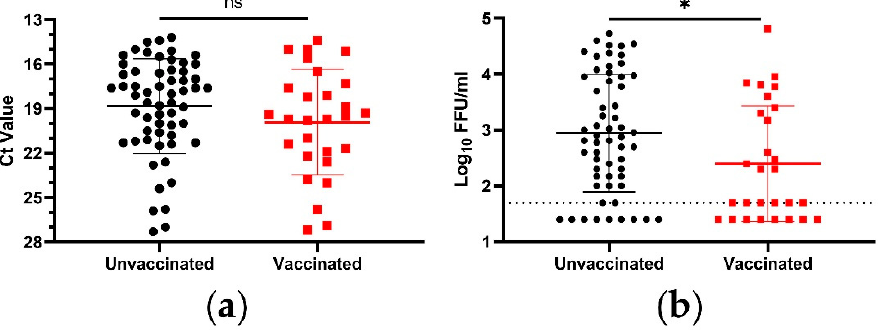
Figure 1. Viral load in NP swabs from asymptomatic Delta variant SARS-CoV-2 infections. ( a ) SARS-CoV-2 RNA was measured using real time RT-PCR. ( b ) Infectious SARS-CoV-2 was measured via a microtiter assay. Symbols represent individual subjects, midlines represent the mean, error bars represent the standard deviation, and dashed lines represent the lower limit of the assay. Unvaccinated and vaccinated groups were compared via Mann–Whitney test. ns = p > 0.05, * = p < 0.05.